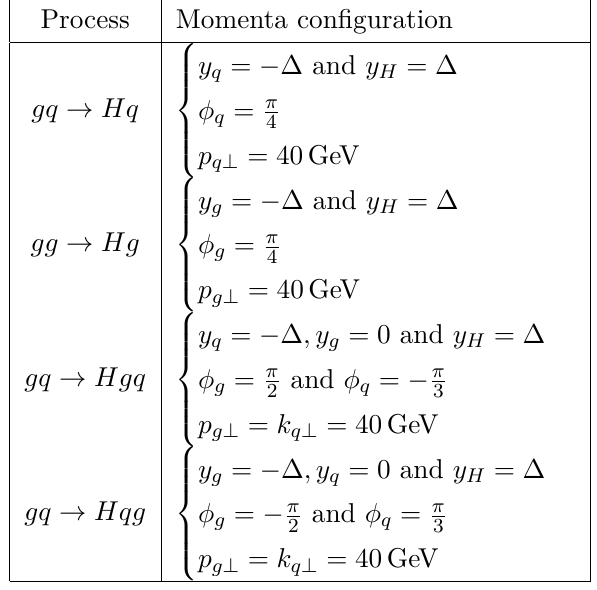
Table 1. The momentum configurations used in figure 3.